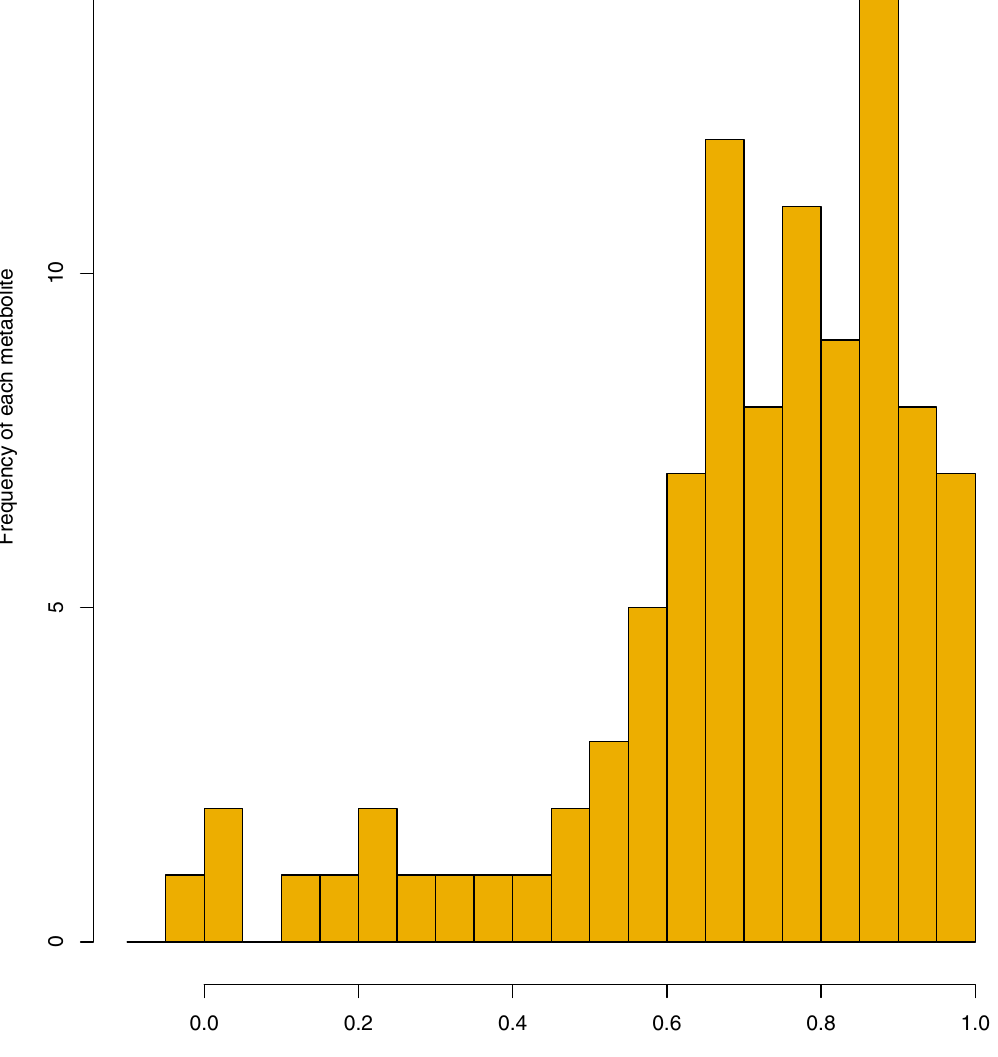
Figure 5. Pearson’s correlation coefficient for 24-h and spot morning urine